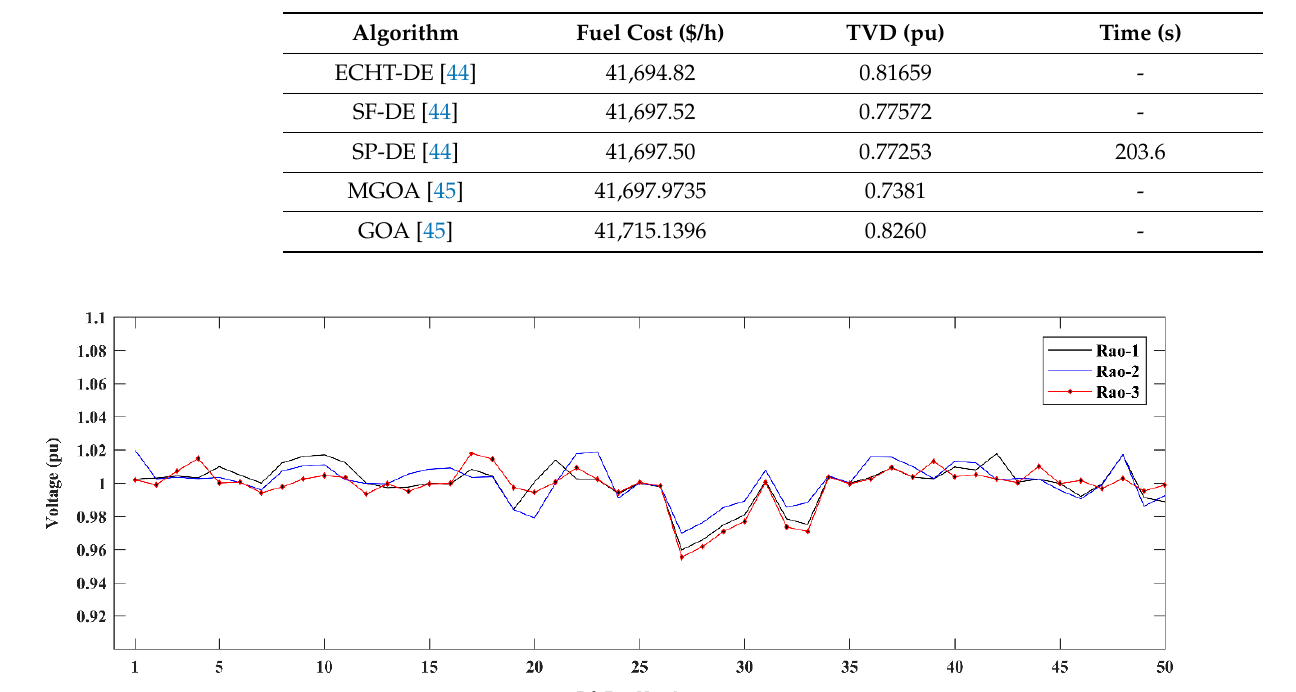
Table 14. Optimum values of control variables of Case 9 and Case 10 for the IEEE 57-bus test system.